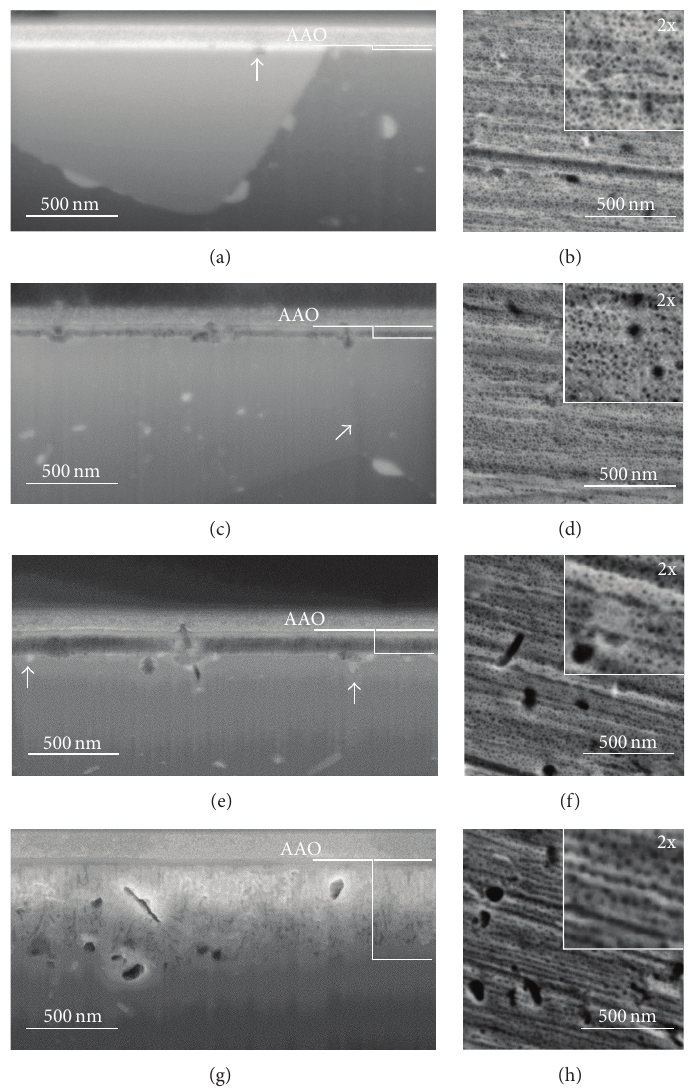
Figure 7: Cross section (left) and surface (right) of AAO films on EN AW-7075 T73 after potentiostatic anodising in 0.4 M sulphuric acid at (a, b) 0.3 V, (c, d) 1.8V, (e, f) 3.8 V, and (g, h) 10 V; the AAO films are marked in the cross sections to clearly distinguish the protective coating on top (bars indicate 500 nm referring to identical magnification except for the twice enlarged